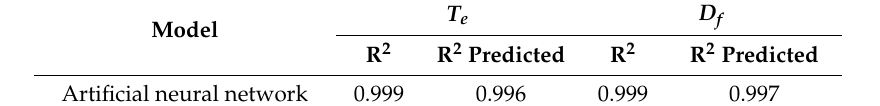
Table 5. Regression coe ffi cients of the artificial neural network models.